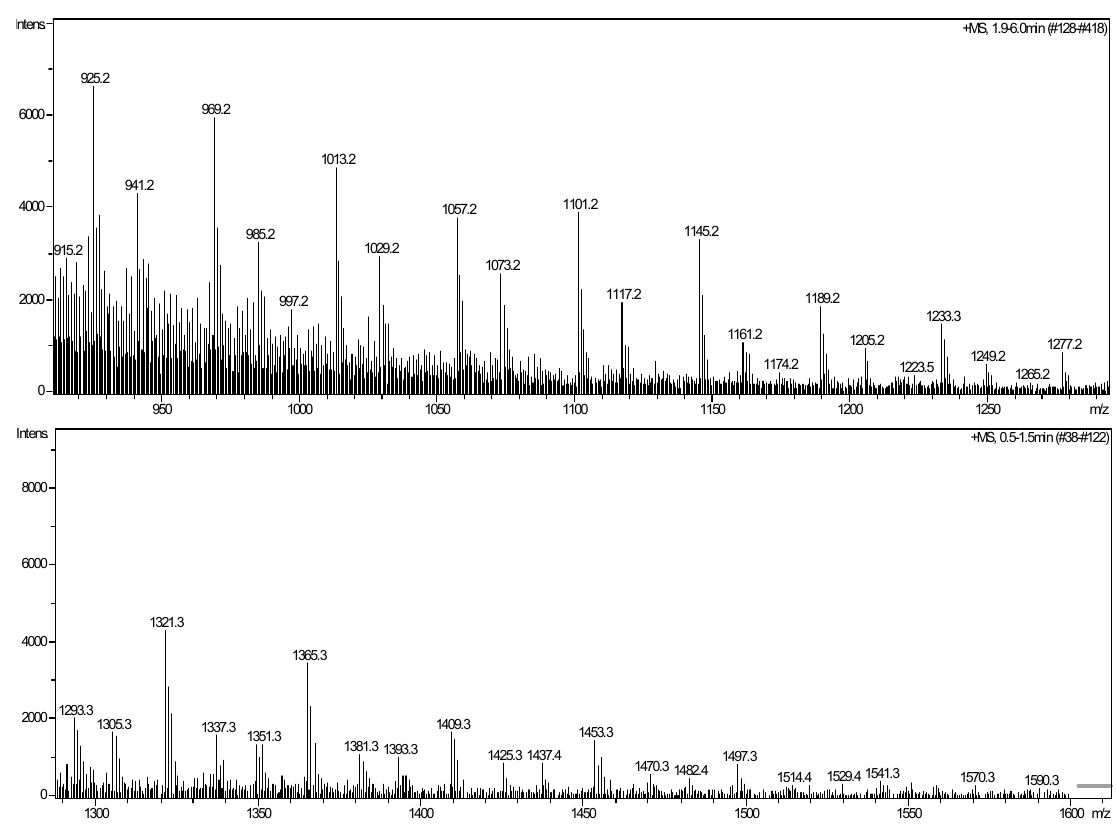
Figure 2. MALDI ‐ TOF mass spectra in the m / z = 925.2–1590.3 Da range correspond to the VS ‐ citral oligomers.